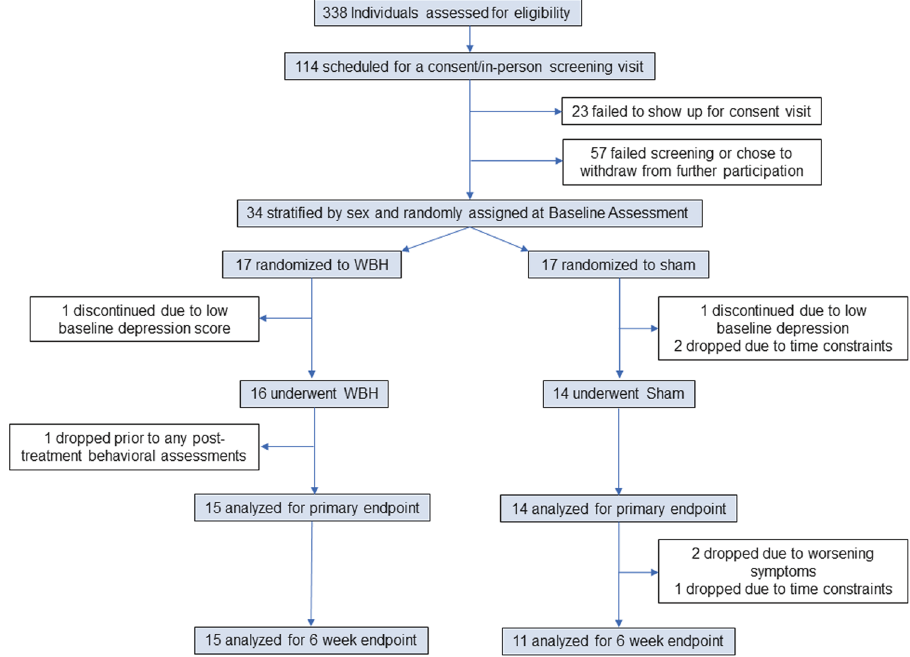
Fig. 1 CONSORT trial fl ow diagram. WBH whole-body